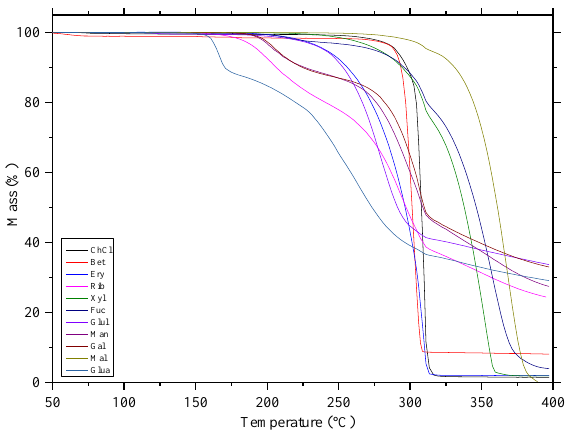
Figure 2. TGA curves of all the components.